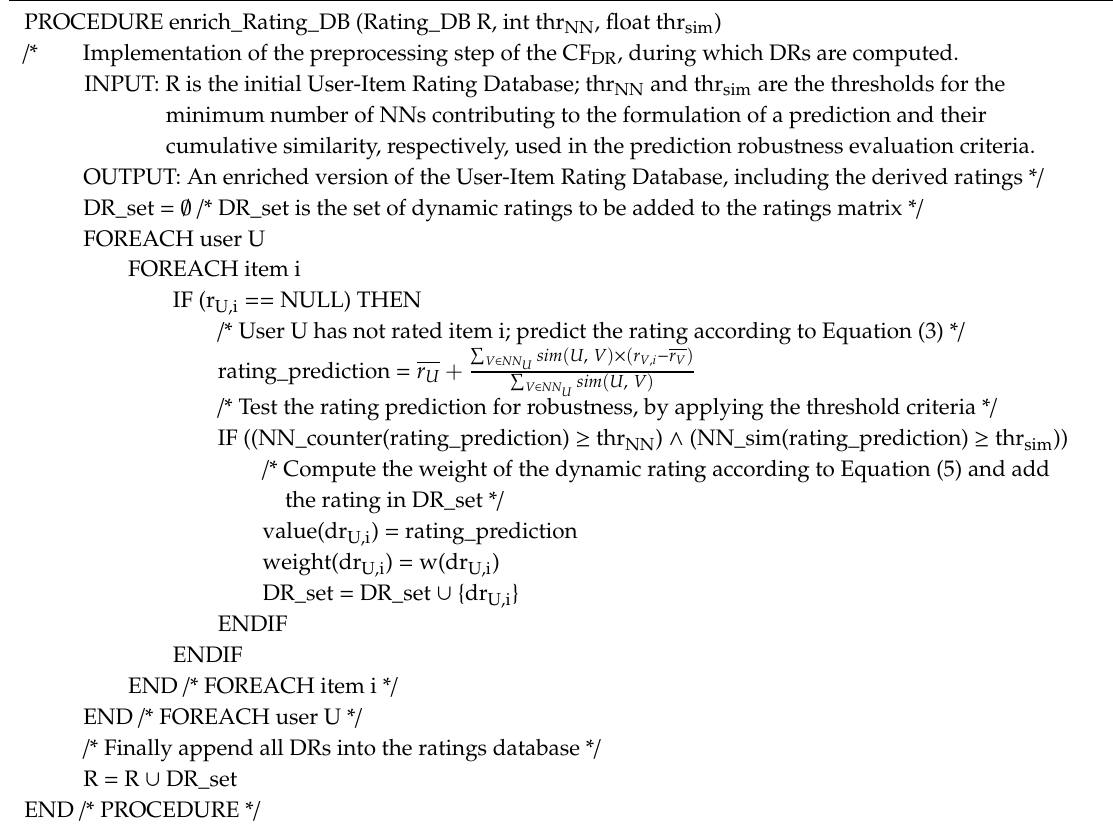
Algorithm 1. Implicit ratings creation and storage, produced by the CFDR algorithm’s preprocessing step.